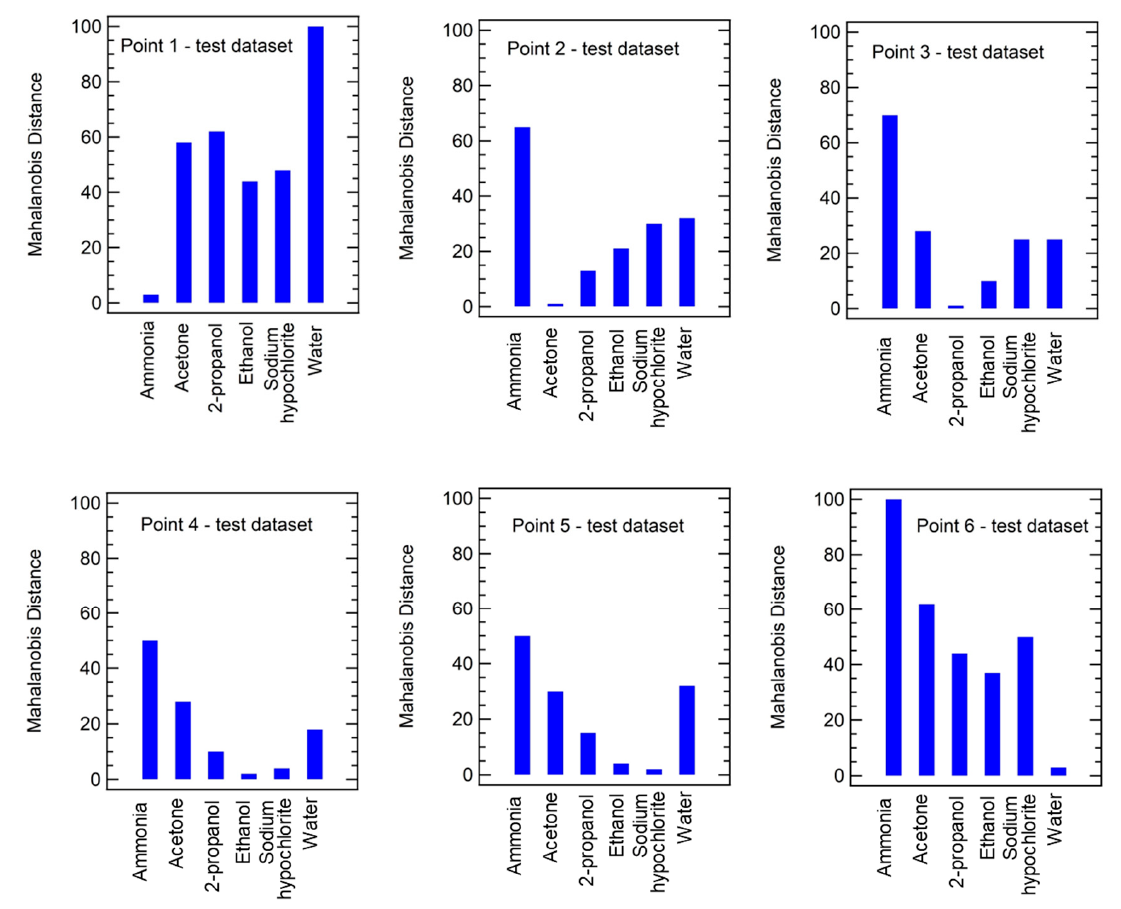
Figure 7. Example of Mahalanobis distances evaluated for each point of the test dataset containing 6 data as function of the 6 gas classes.